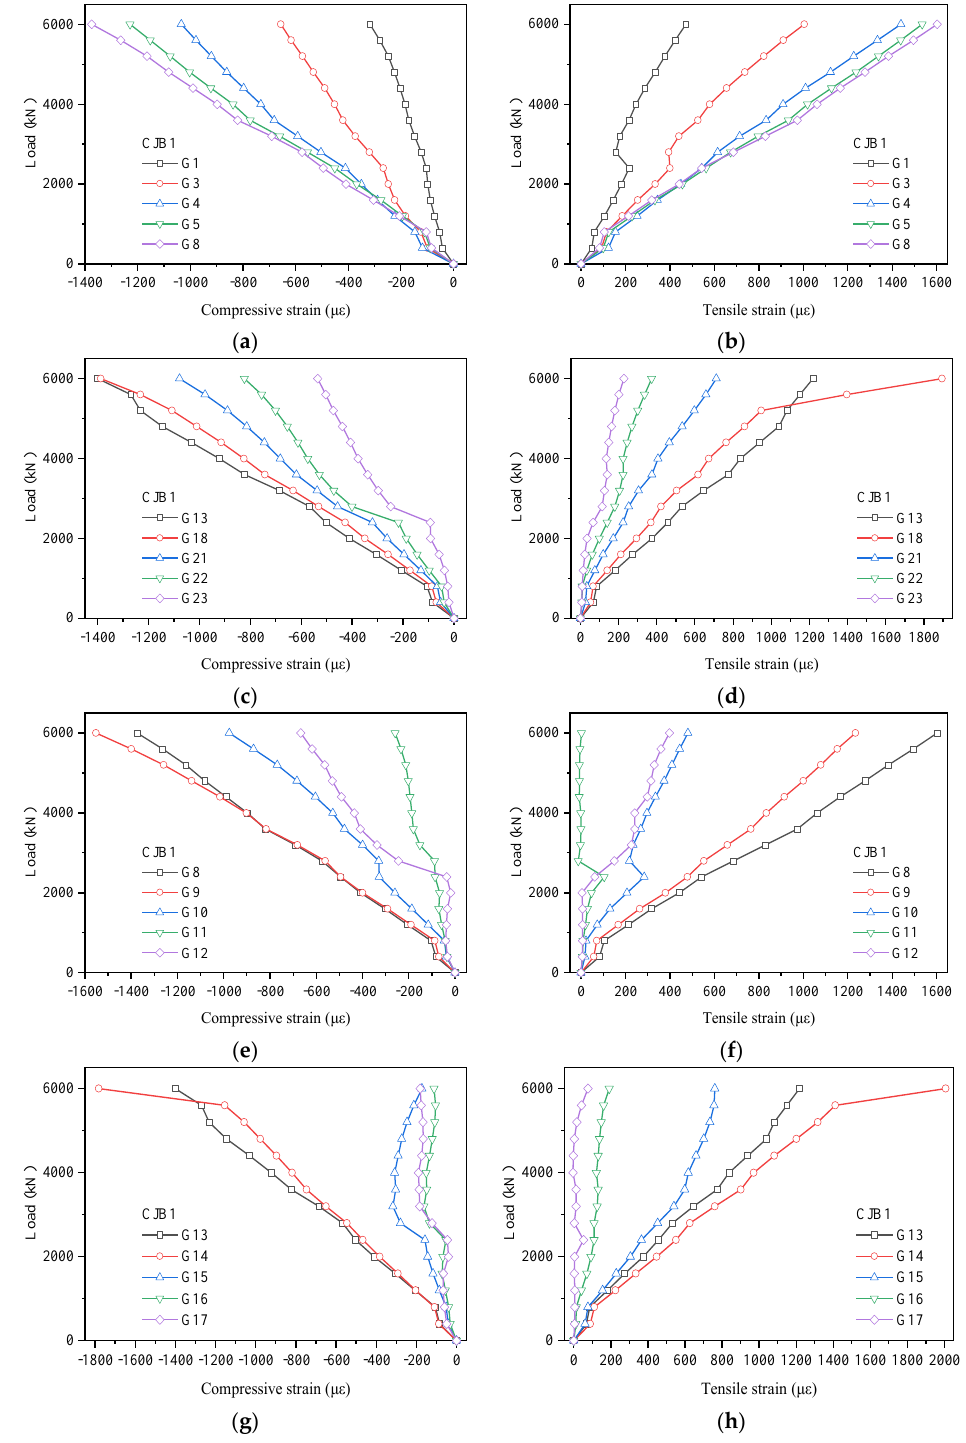
Figure 14. Load–strain curves of CJB1 (cid:48) s gusset plate. ( a ) compressive strain from G1 to G8; ( b ) tensile strain from G1 to G8; ( c ) compressive strain from G13 to G23; ( d ) tensile strain from G13 to G23; ( e ) compressive strain from G8 to G12; ( f ) tensile strain from G8 to G12; ( g ) compressive strain from G13 to G17; ( h ) tensile strain from G13 to